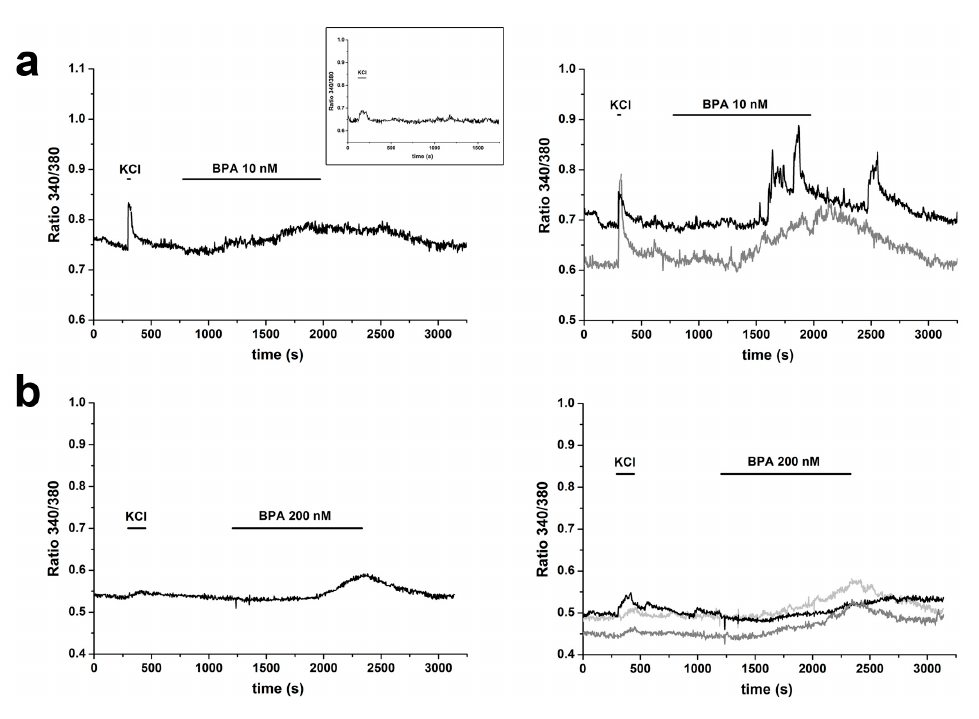
Figure 2. Cont. Figure 2.